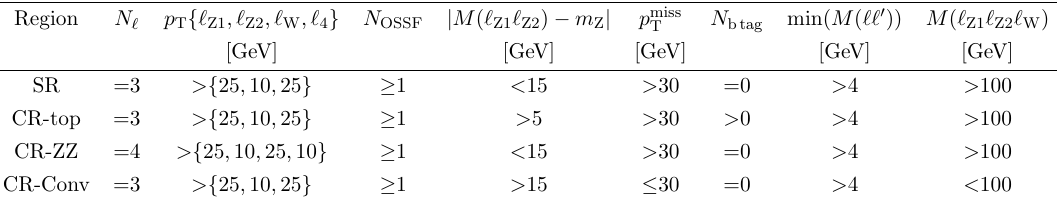
Table 1 . Requirements for the de(cid:12)nition of the signal region of the analysis and the three di(cid:11)erent regions designed to estimate the main background